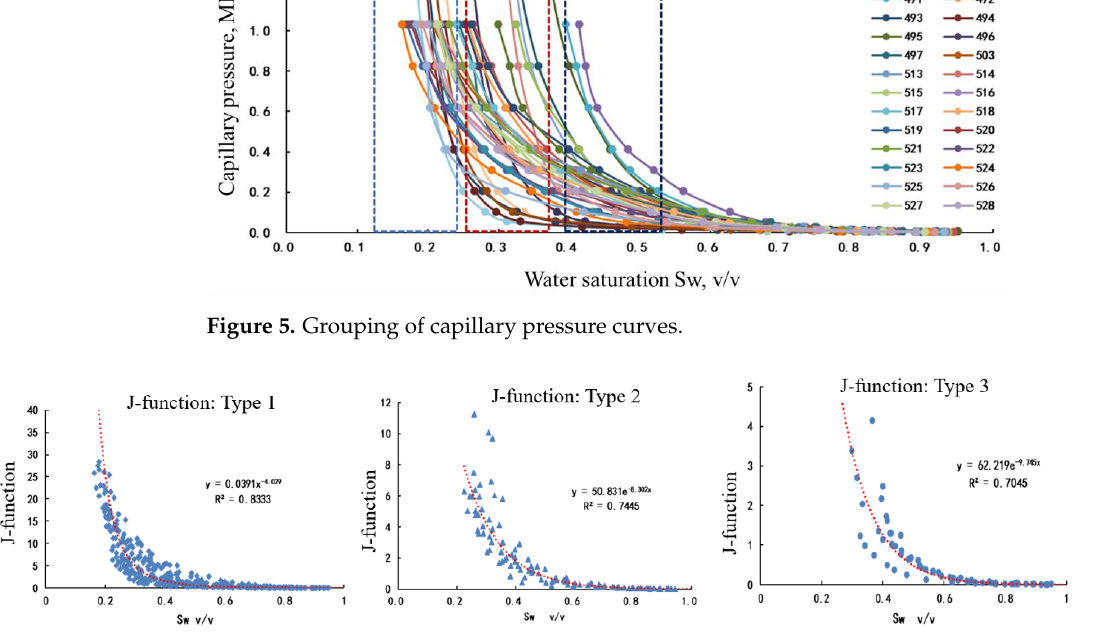
Figure 6. J-functions of grouped capillary pressure curves.